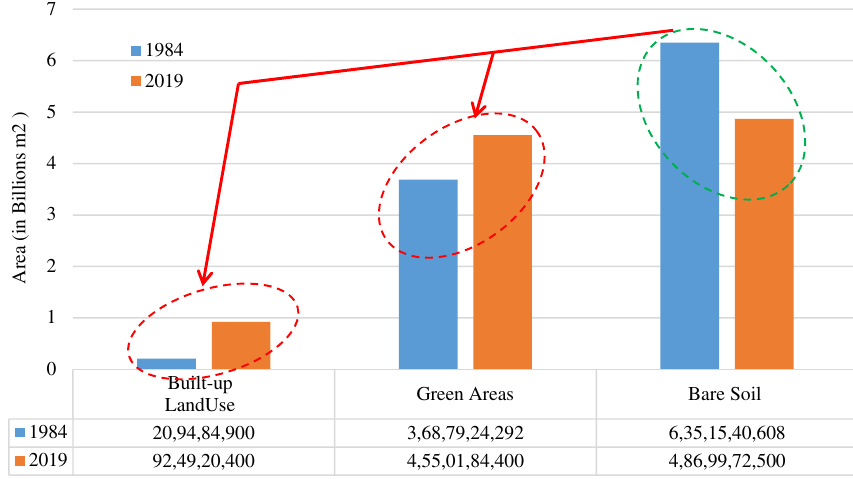
Fig. 15 Evolution of land use Areas between 1984 and 2019